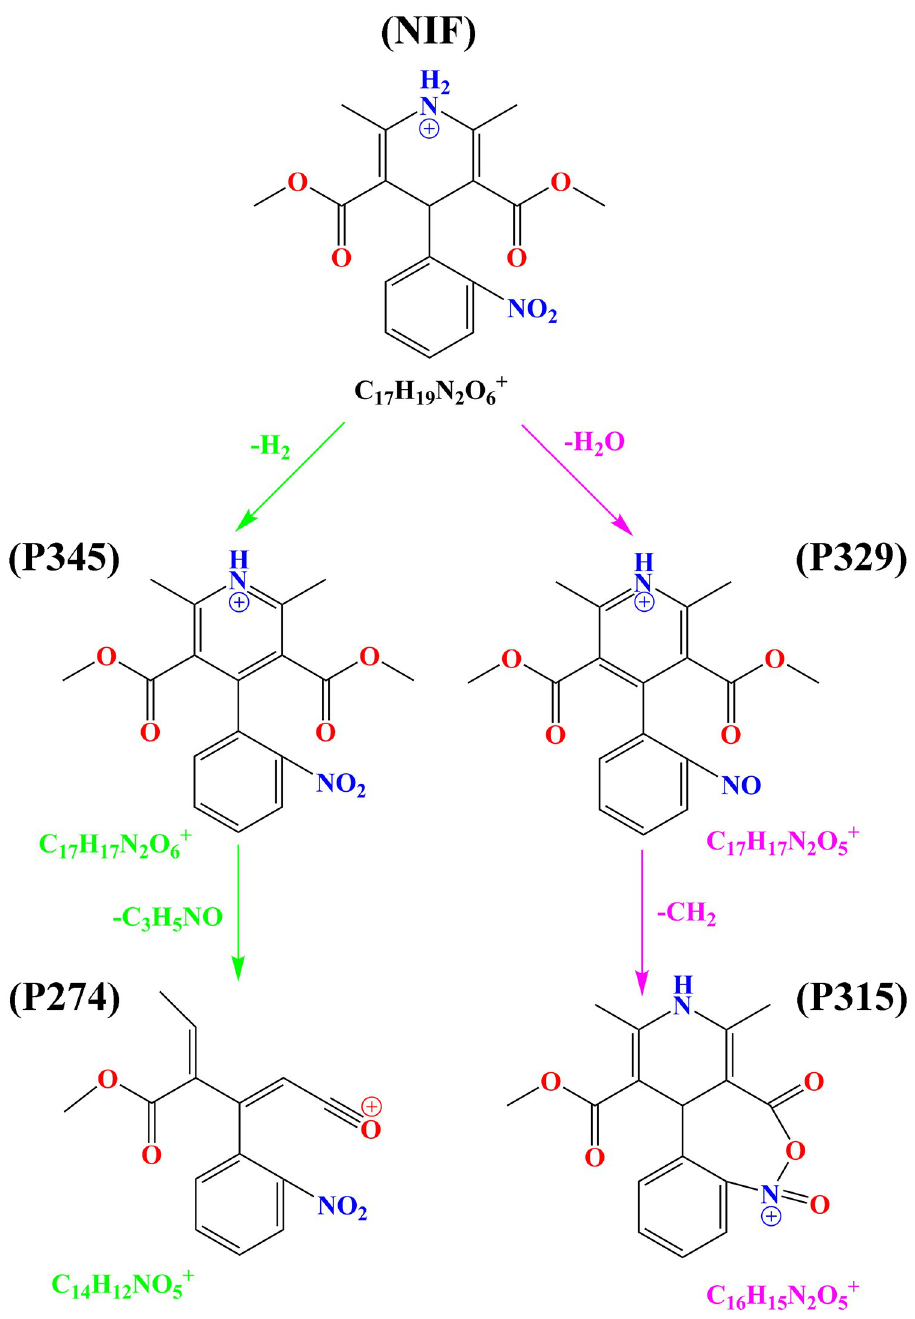
Fig 11. Degradation pathway of NIF via UV/H 2 O 2 system. C H NO to generate P200 (C 4 7 2 P158 (C H NO + , m/z = 158) [46]. 10 8